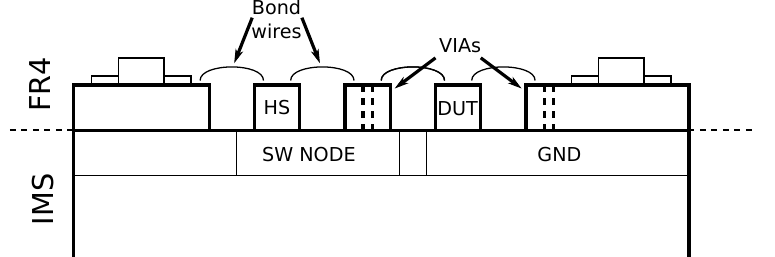
Figure 4. Lateral section of half-bridge module.